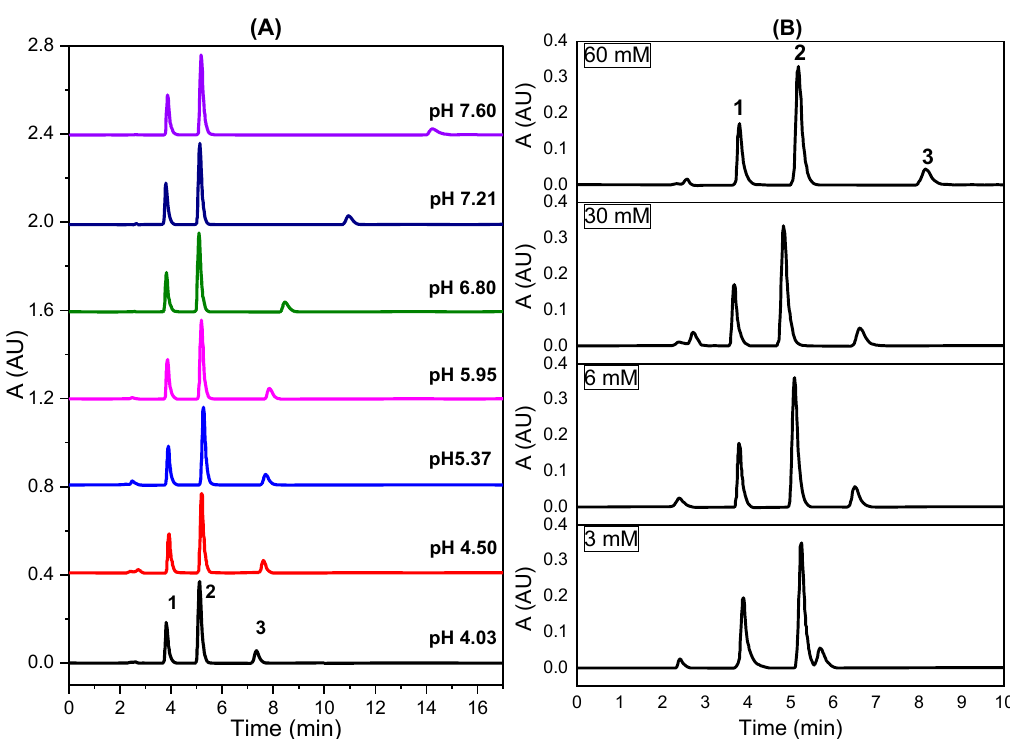
Figure 2. Chromatograms showing the separation of the three drugs using the selected 40% MeOH of the mobile phase at various ( A ) pH values and ( B ) phosphate concentrations (pH 4.5). Molarity values included in the picture ( B ) correspond to the phosphate concentration in the mobile phase (1: paracetamol; 2: caffeine; 3: tramadol). Other parameters as in Figure 1.